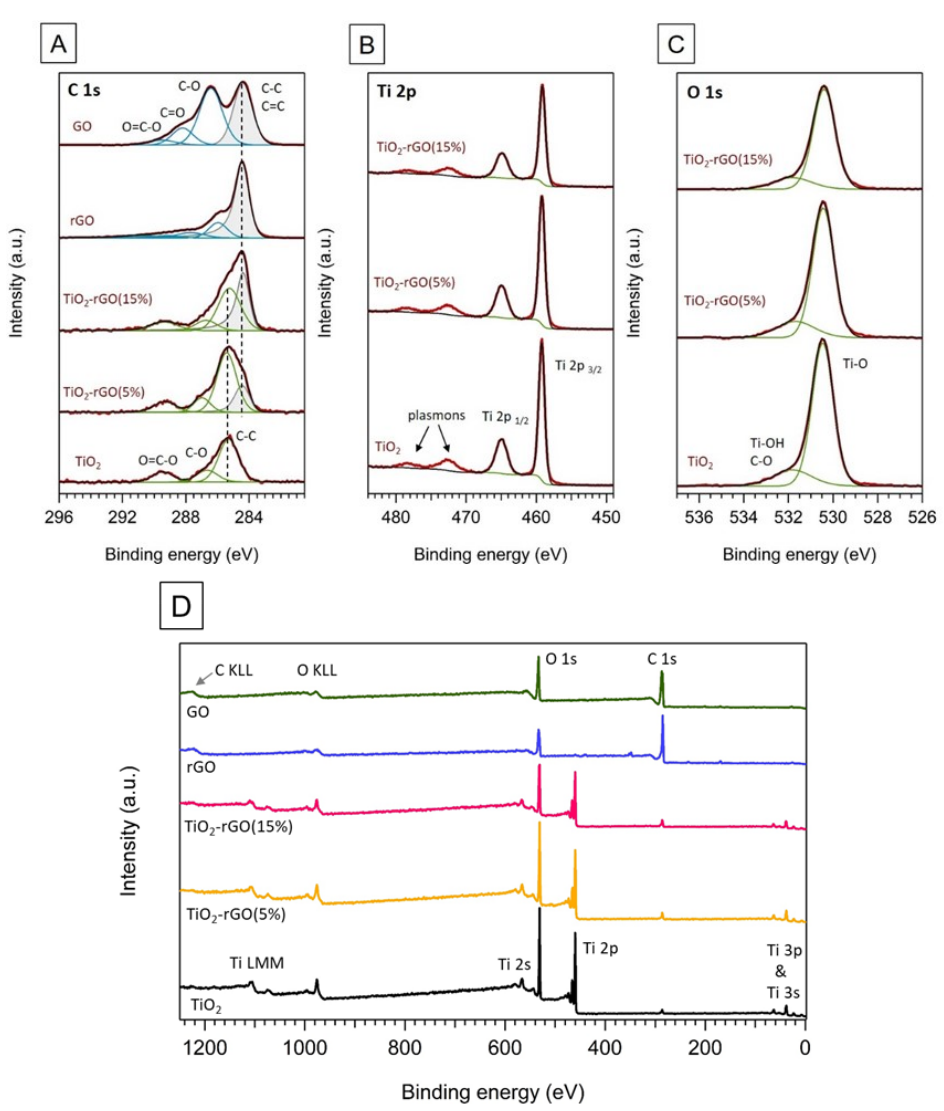
Figure 4 . ( A ) C 1s, ( B ) Ti 2p, and ( C ) O 1s high-resolution XPS spectra of TiO 2 and TiO 2